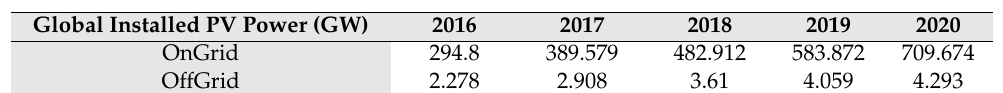
Table 1. Global installed PV power (GW)